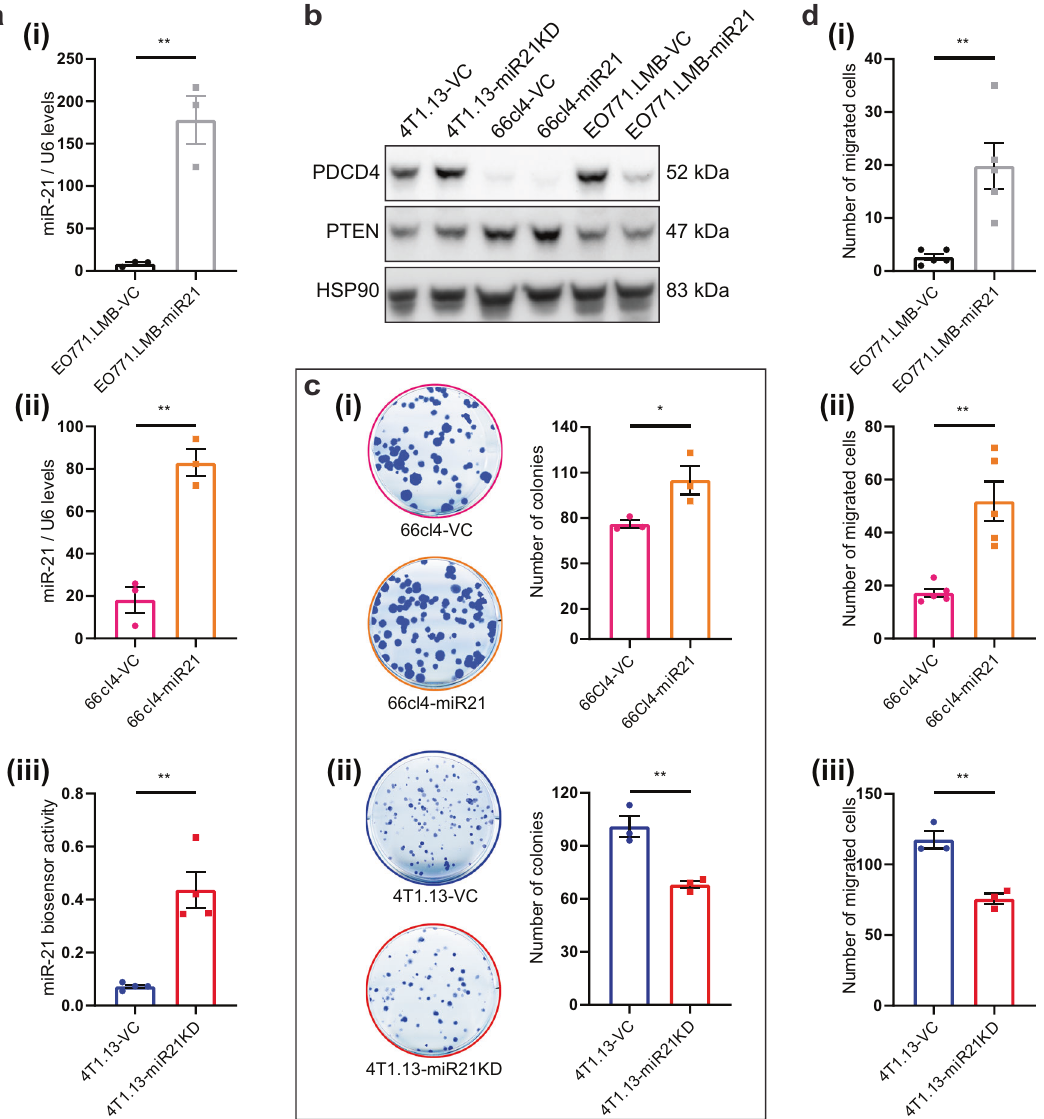
Fig. 2 Effect of miR-21 on the phenotype of mammary cancer cells. a Con fi rmation of elevated expression of miR-21 in EO771.LMB and 66Cl4 tumour lines and suppression of miR-21 activity in 4T1.13 cells. For (i-ii), miR-21 transcript levels were normalised to expression of Rnu6 small nuclear RNA (U6). Mean ± SEM ( n = 3). For (iii), reduced miR-21 activity was con fi rmed using a miR-21 speci fi c luciferase-based reporter gene assay. Mean ± SEM ( n = 4). b Western blot analysis of the miR-21 targets PDCD4 and PTEN in miR-21 modulated mouse mammary tumour lines. Heat shock protein 90 (HSP90) was used a loading control. c Extent of colony formation in 66cl4 and 4T1.13 cells after modulation of miR-21 activity. Mean ± SEM ( n = 3). d Extent of chemotactic migration of EO771.LMB (i), 66cl4 (ii) and 4T1.13 (iii) cells after modulation of miR-21 activity. Mean ± SEM ( n = 3 – 5). * p < 0.05; ** p < 0.01. proteins involved in cell death, cleaved caspase 3 and BAX, pathways and terms relating to increased immune activity when showed a trend towards increased levels when miR-21 was miR-21 levels were reduced (Fig. 5b). Gene set enrichment analysis reduced (Fig. 5f, g). When assessed in vitro, western blotting con fi rmed signi fi cant down-regulation of genes involved in cell analysis of the levels of these proteins con fi rmed reduced cyclin cycle activity (Fig. 5c), and upregulation of genes involved in D1 and phospho-histone H3 protein levels and increased caspase cytokine-cytokine receptor interactions (Fig. 5d), T cell receptor 3 processing, but no signi fi cant change in BAX levels was signalling (Fig. 5e) and NK cell mediated cytotoxicity (Fig. S4d) in observed (Fig. 5h). miR-21-KD tumours. These results are consistent with the Since the second mechanism of action of miR-21 in the observed decrease in 4T1.13-miR-21-KD tumour growth (Fig. 3c) promotion of metastasis appeared to be independent of and increased immune cell in fi ltration (Fig. 4). regulation by the immune system, we subjected both EO771.LMB To validate changes in cell cycle and cell death pathways, we and 4T1.13 cultured cells with and without modi fi ed miR-21 immunostained primary 4T1.13 tumours with or without knock- activity to proteomic analysis by mass spectrometry (Fig. 6a, down of miR-21 with relevant antibodies, demonstrating that loss Fig. S7). To analyse these data, we initially set out to complete of miR-21 reduced markers of cell cycle progression, namely pathway analysis using gene set enrichment analysis (GSEA). phospho-histone H3 and cyclin D1 (Fig. 5f, g). Assessment of Oncogenesis (2022)